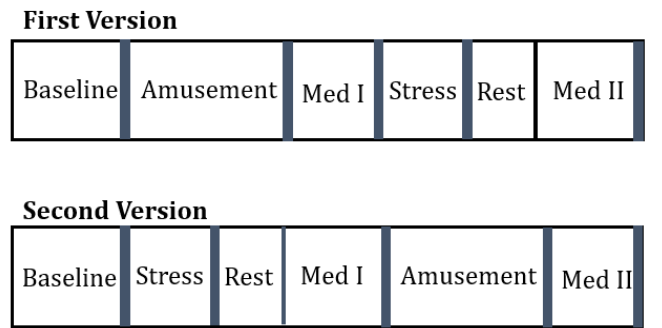
Figure 2. The two protocols tested under this study. The blue bars indicate the times when the study participants filled out questionnaires for self-report. Adapted from [18].